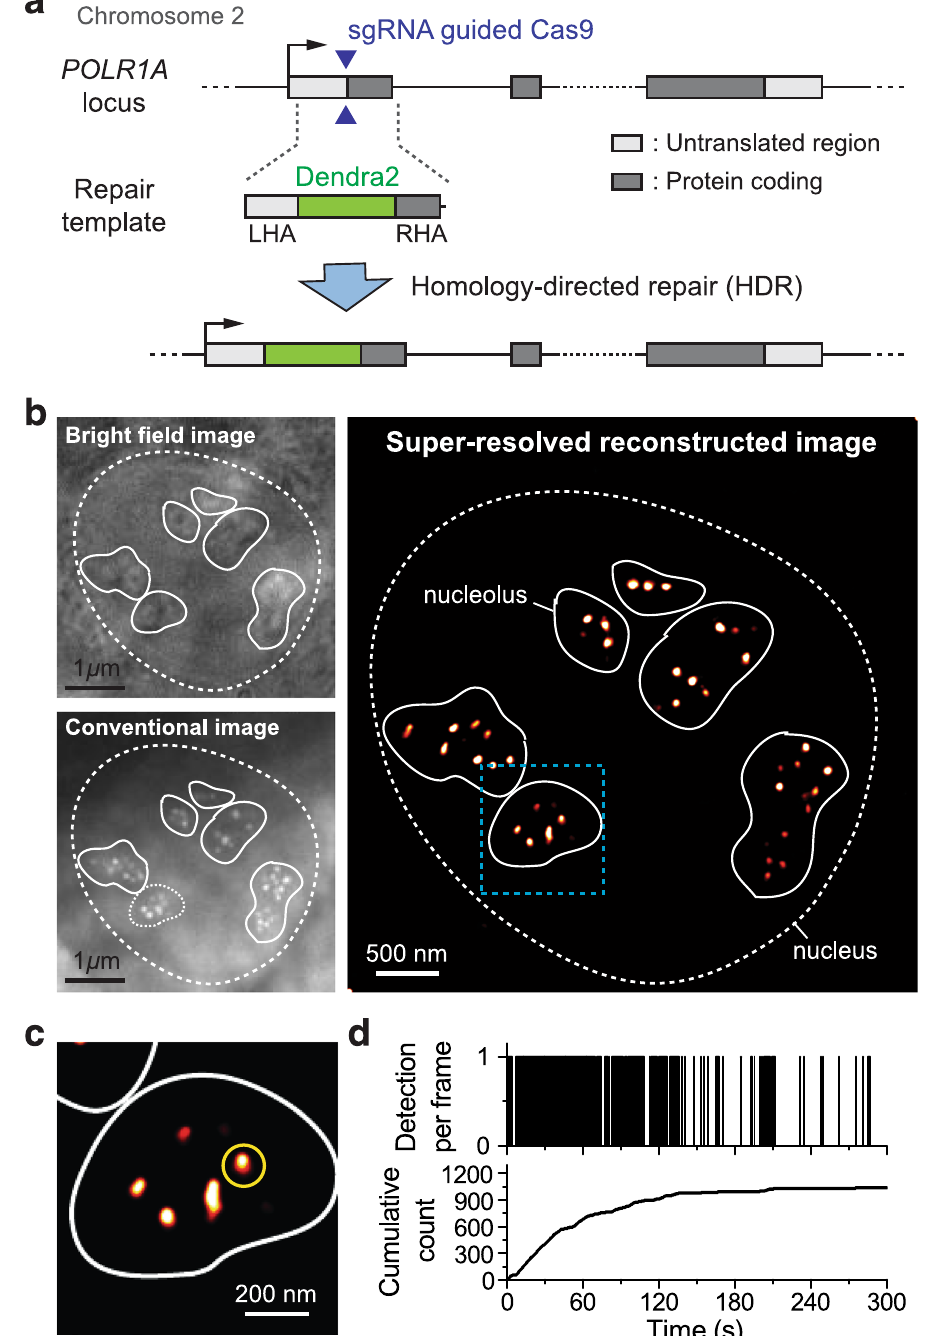
Figure 2. Interphase Organization and Dynamics of RNA Pol I. ( a ) A homologous donor vector containing the Dendra2 fluorescence protein flanked by two 500 bp homologous arms. When co-transfected with a plasmid expressing Cas9 along with a targeted sgRNA, homology directed repair at the protospacer adjacent motif (PAM) cut site induces insertion of the Dendra2 sequence onto the N-terminus of the RPA194, the largest subunit of RNA Pol I. We imaged a total of 77 cells on seven separate days. ( b ) Bright-field and conventional fluorescence imaging of the pre-converted state of Dendra2-RPA194 in a U2OS cell line. The nucleus is demarcated with a dashed line while the contours of the nucleoli are demarcated with a solid white line. The polymerase appears to cluster in distinct foci within the nucleoli. ( c ) Super-resolution reconstruction of the Dendra2-RPA194. At the super-resolution level, foci remain visible. ( d ) A sample time trace of the cluster marked in yellow in the super-resolution image. In the cumulative trace, the detections show an initial linear slope indicating that the cluster was pre-existing and slowly level off suggesting that the cluster is